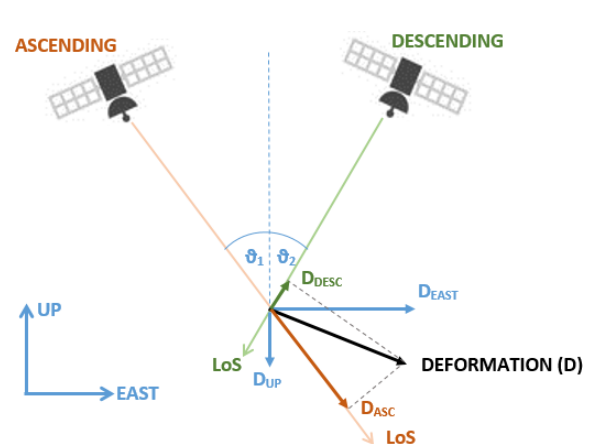
Figure 4. Decomposition of the total deformation into ascending and descending LOS components as well as to into vertical and quasi-horizontal (east–west)